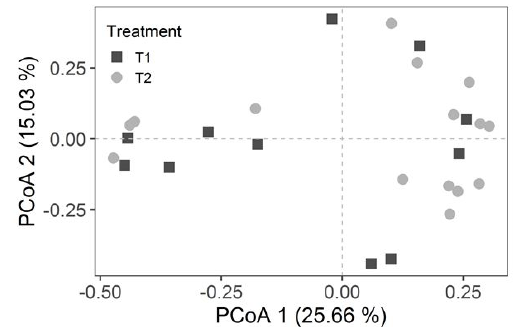
Figure 5. Ordination diagram of the Principal Coordinates Analysis (PCoA) based on the periphytic algal composition from the food content of Moenkhausia sanctaefilomenae between T1 (without zooplankton) and T2 (with zooplankton) treatments.